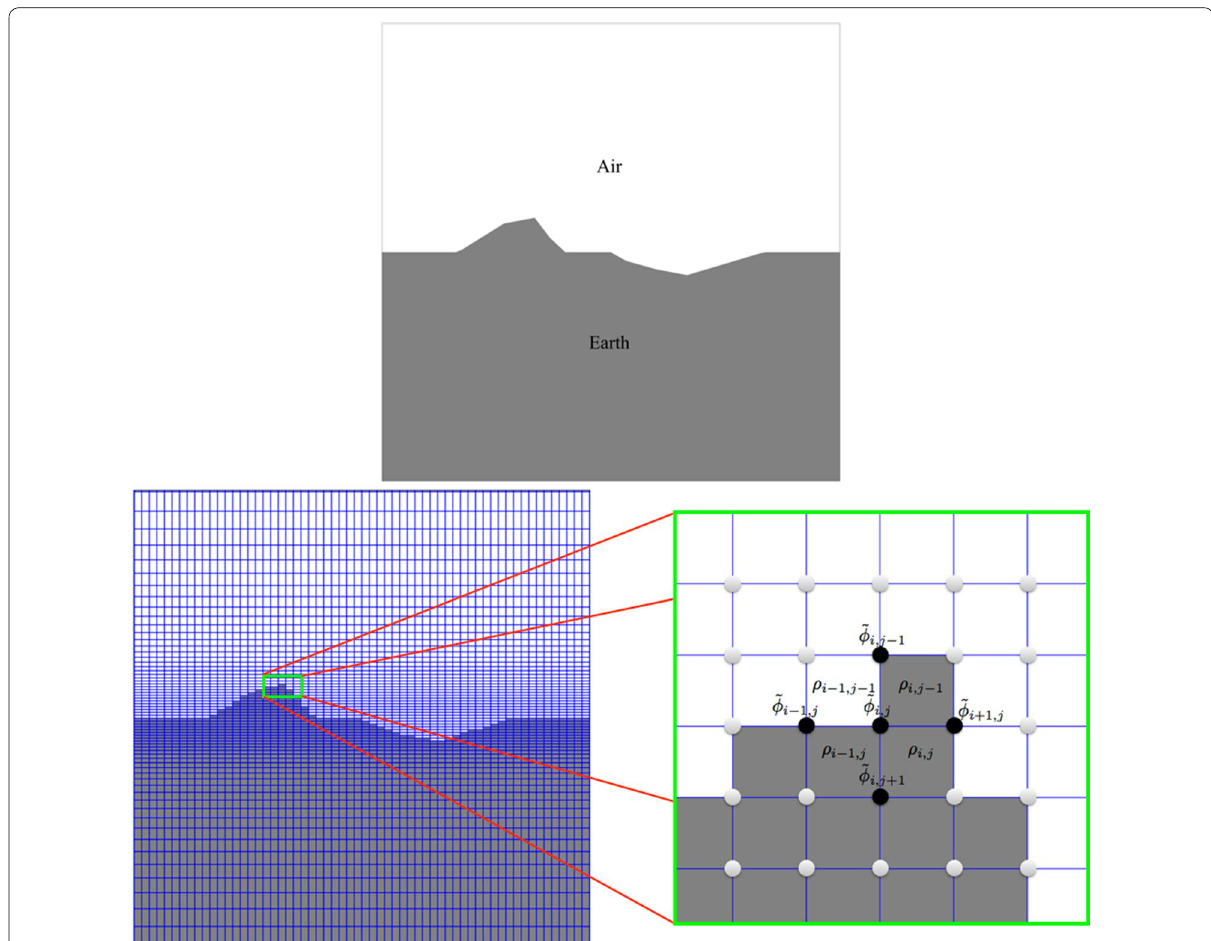
Fig. 1 The resistivity model with terrain (top). The discrete model with rectangular blocks (left bottom). The approximation of field ˜ φ by using the four neighbor nodes is demonstrated (right